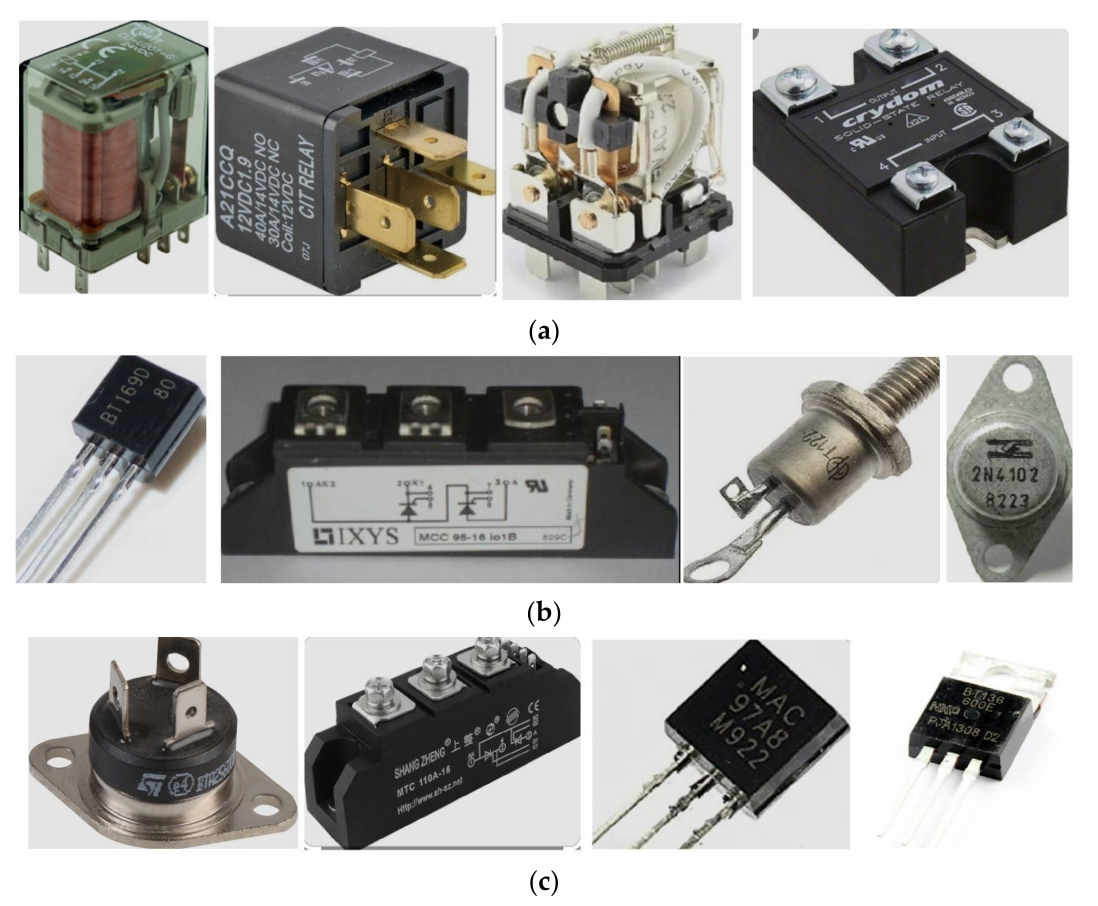
Figure 10. ( a – c ) Some typical electromechanical relay, SCRs, and TRIACs, respectively [75,113], Courtesy of the Zhejiang NCR Industrial Co., Ltd, China; and EASTRONIC THCHNOLOGY CO., LTD.,